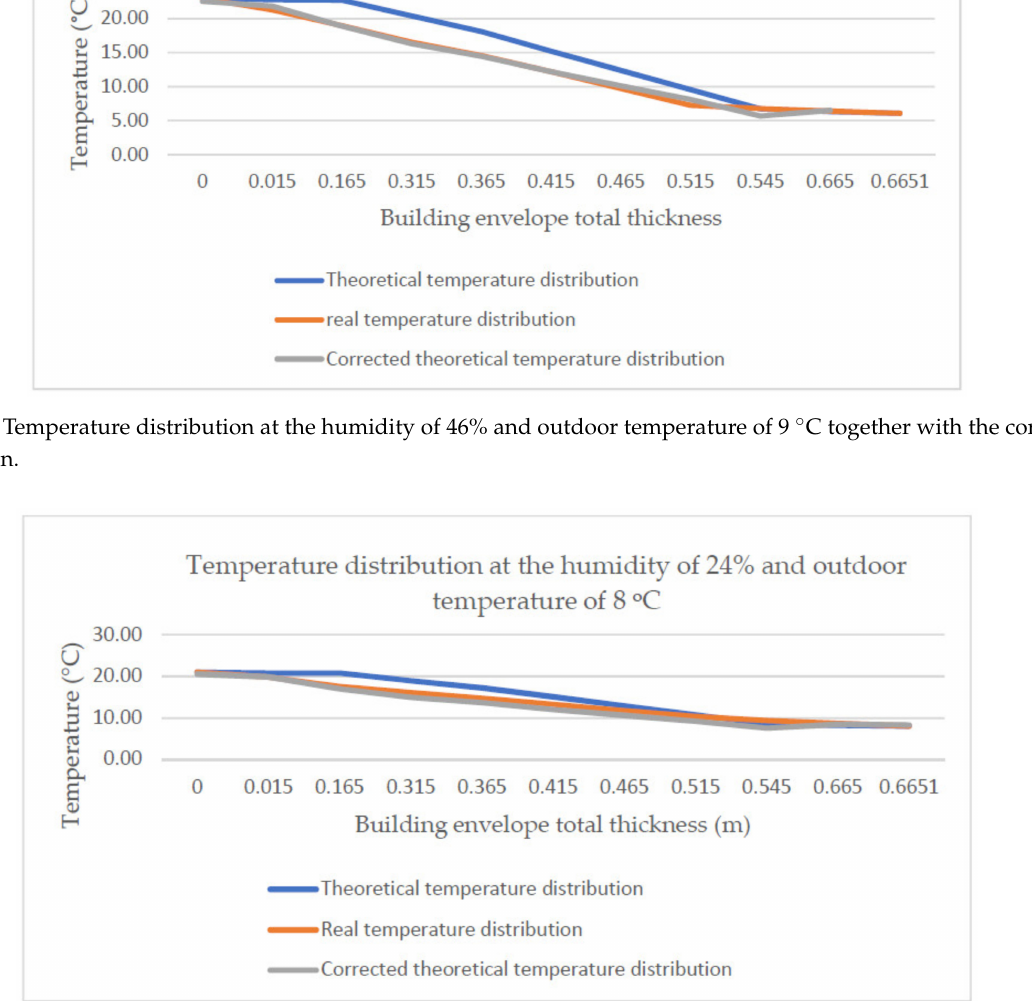
Figure 18. Temperature distribution at the humidity of 24% and outdoor temperature of 8 ◦ C together with the corrected